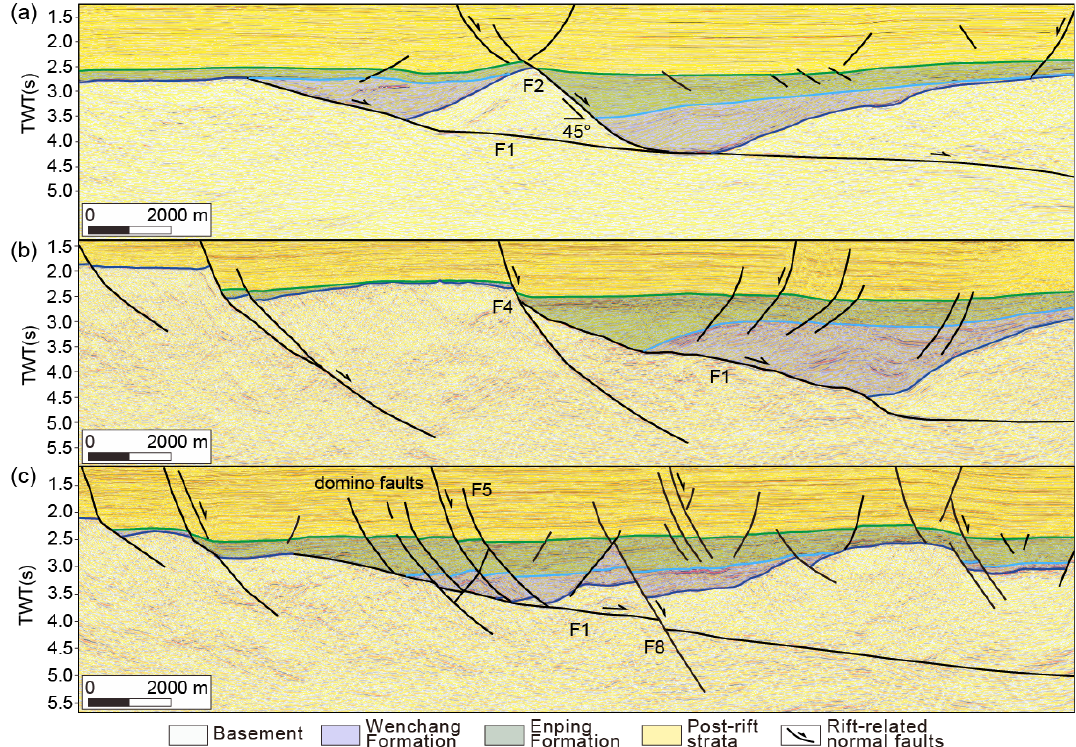
Figure 9. Cross sections showing interaction styles between the low-angle major fault and high-angle faults found in the Enping sag: (a) “merging fault” that joins together at the lower tips (F1 and F2), (b) “abutting fault” that initiates at the low-angle normal fault (F1 and F4), (c) abutting fault (F1 and F5), and (d) “cross-cutting fault” that offsets the low-angle normal fault (F1 and F8). See Fig. 1 for the location of these cross sections.